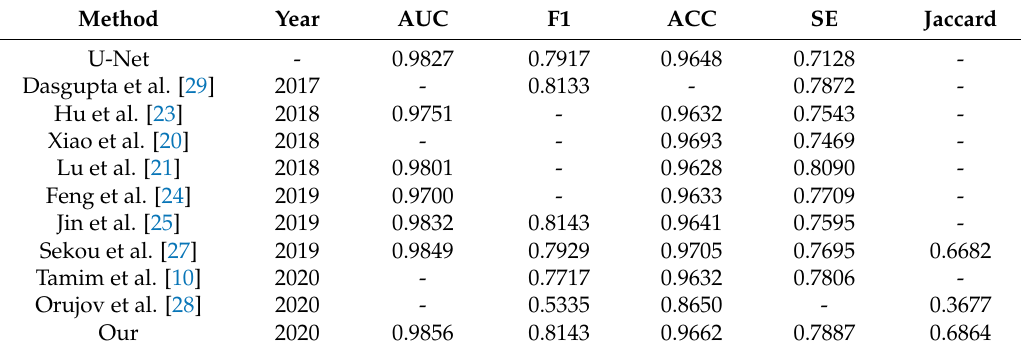
Table 2. Evaluation of STARE